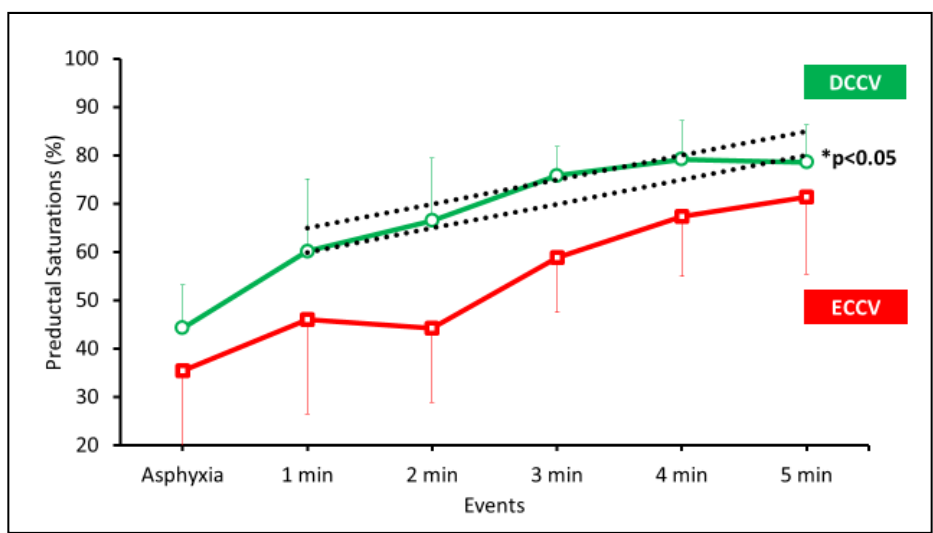
Figure 1. Preductal SpO 2 are shown on the y-axis and the events or duration of positive pressure ventilation (PPV) on the x-axis. The data are represented as average and standard deviation. The SpO 2 between ECCV (early cord clamping followed by ventilation) and DCCV ( delayed cord clamping with ventilation ) was significantly different (* p < 0.05 by ANOVA).